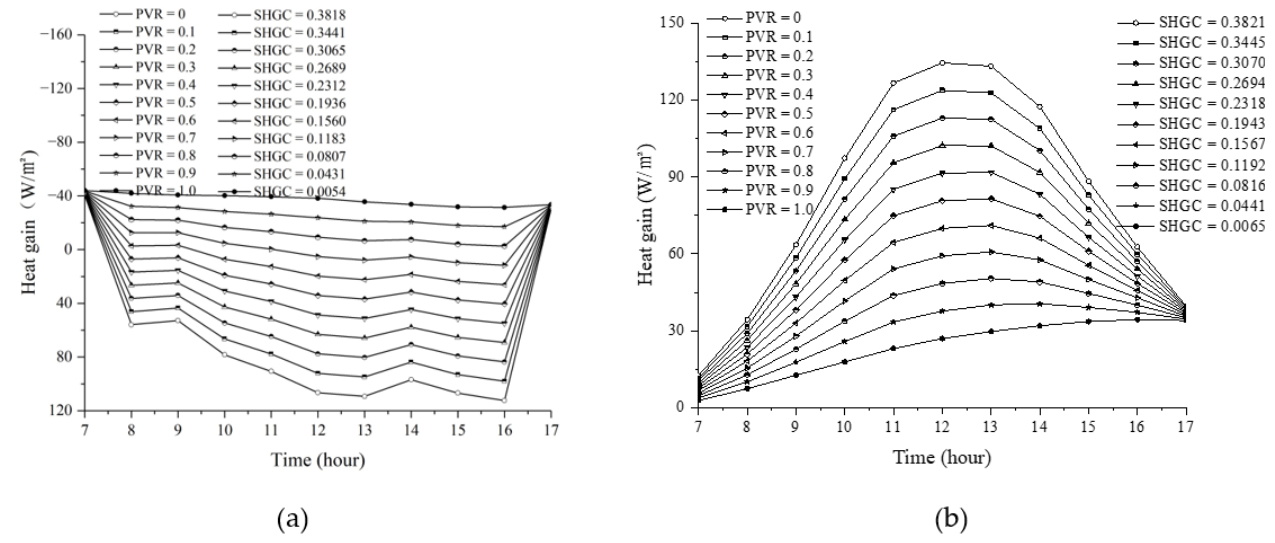
Figure 5. Effect of PVR on thermal performance of ST-PVW in Nanjing: ( a ) The relationship between PV window PVR and summer heat gain; ( b ) The relationship between PV window PVR and winter heat